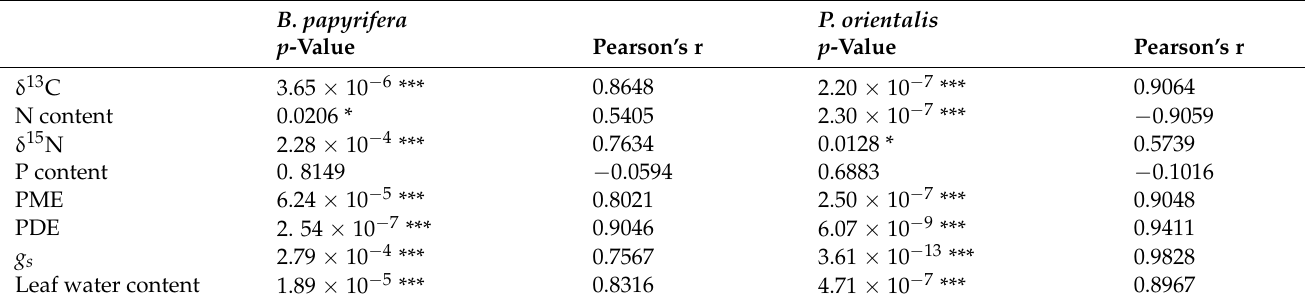
Table 1. p -value and Pearson’s r between soil water content and N content, P content, δ 13 C, δ 15 N, PME, PDE, g s , and leaf water content.